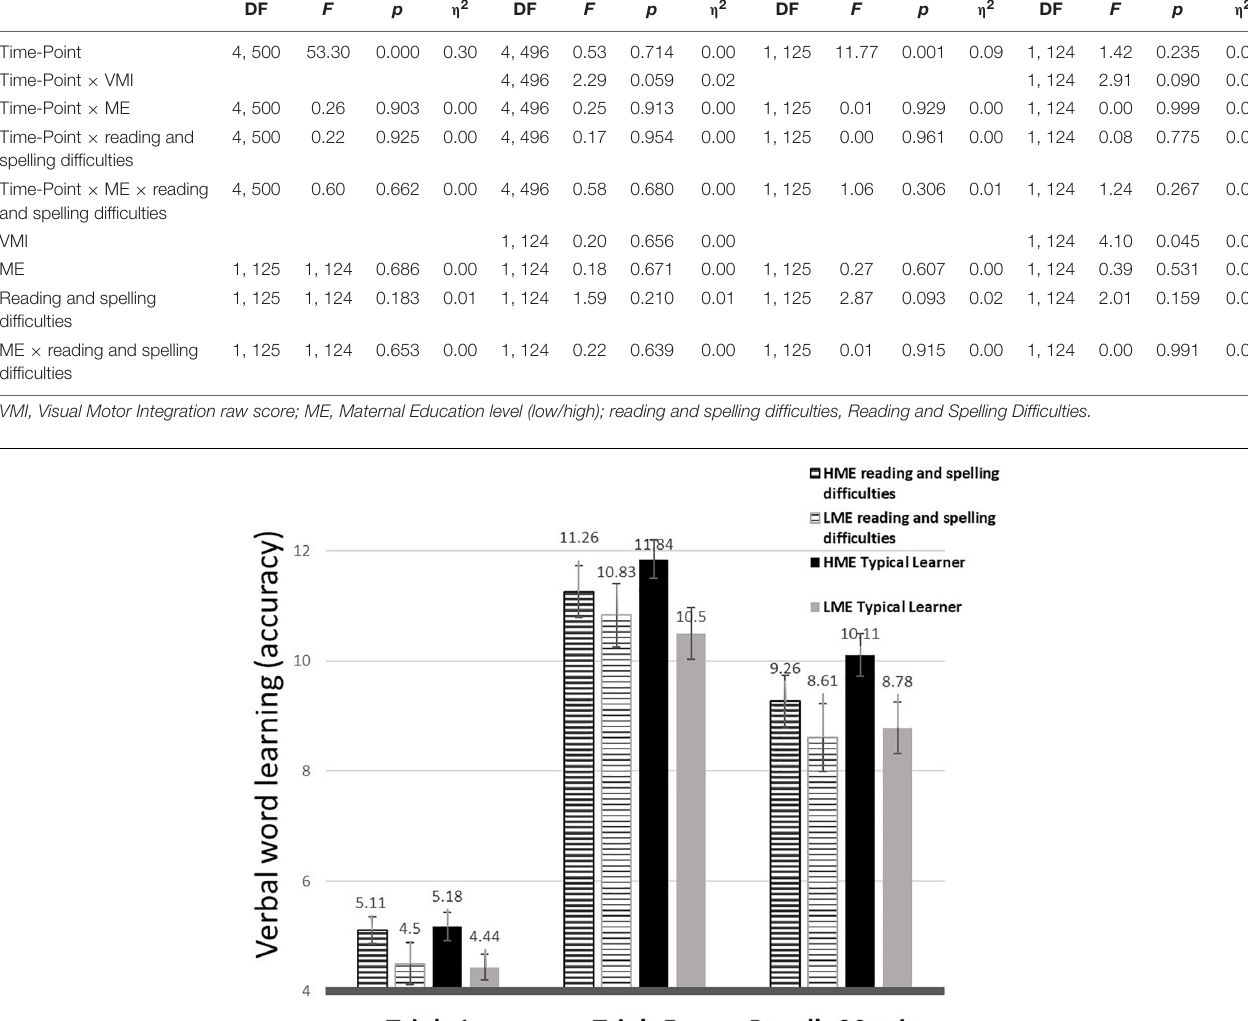
municipality, were children with reading and spelling